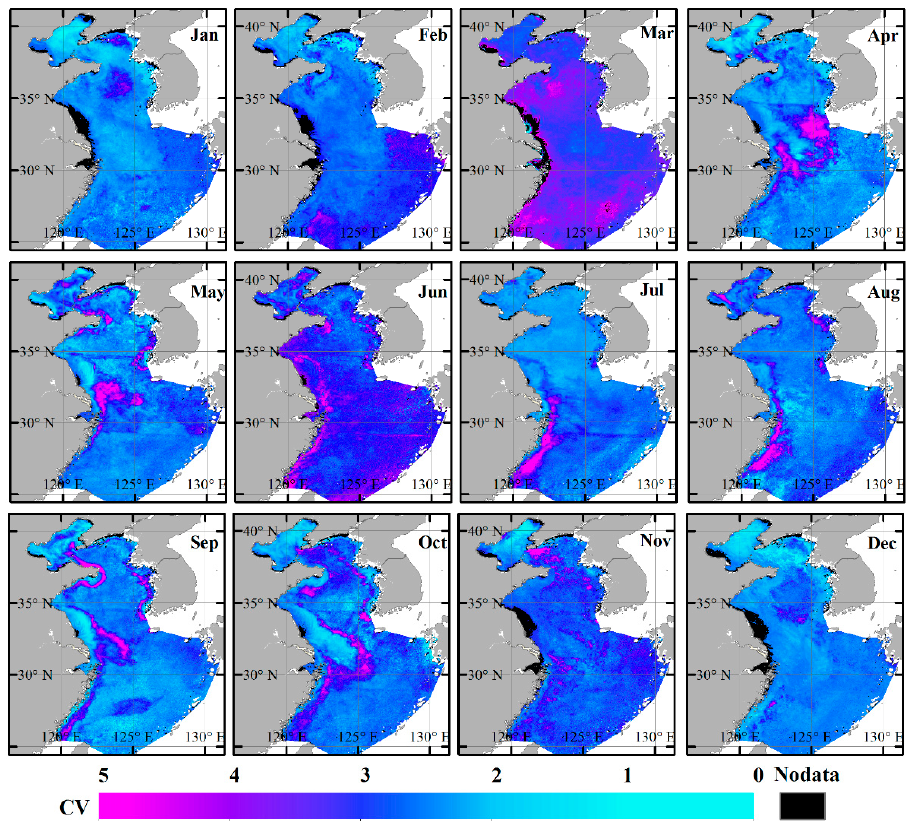
Figure 10. CV for monthly TSS levels in China’s seas from GOCI observations from 2013 to 2017.